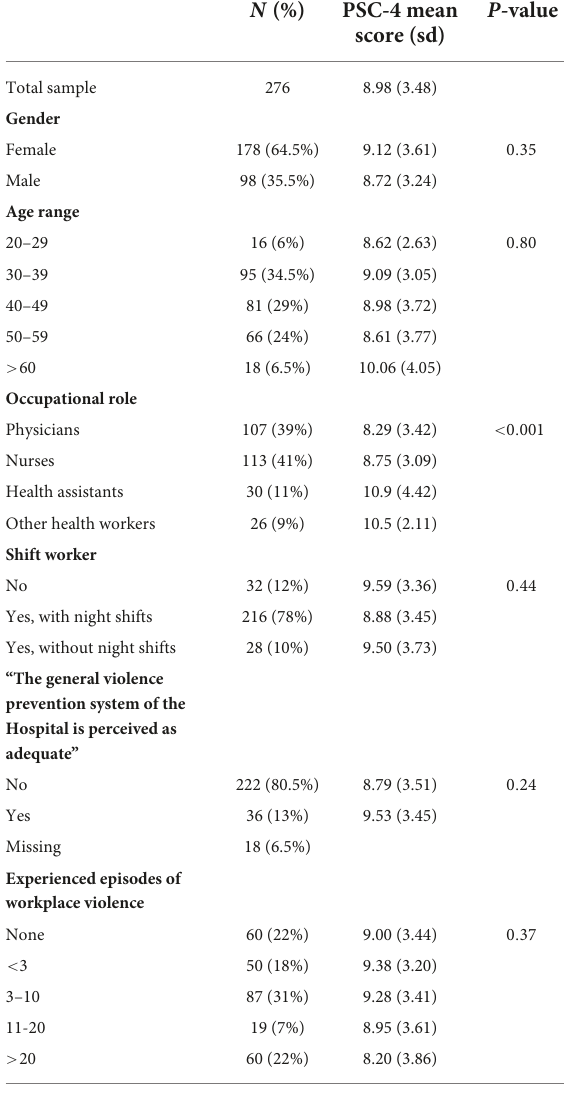
TABLE 2 Sociodemographic and occupational characteristics of the study